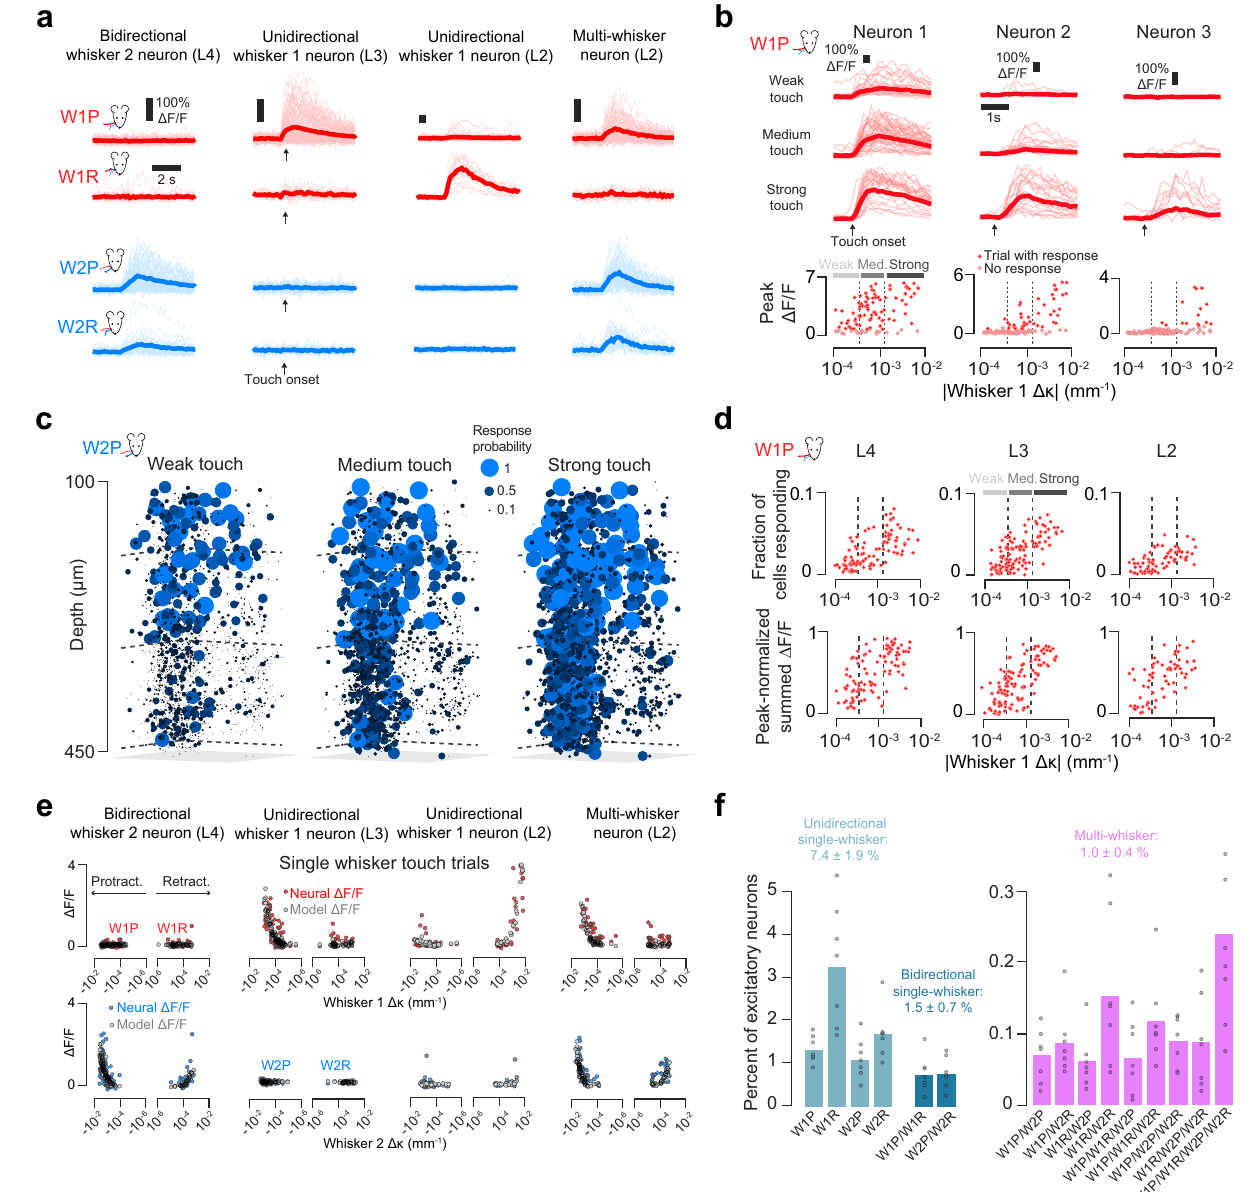
Fig.2|Classi fi cationoftouch-sensitiveneurons.a Example Δ F/Fresponsestoall single-whisker touchtypesforfour neurons. Thickline,mean;thinlines,individual touch responses. b Example responses to W1P touch for three neurons. Top, Δ F/F, grouped by touch intensity (weak: bottom third trial Δ κ ; medium: middle third; strong: top third; thick lines, mean; thin lines, individual touches). Bottom, responseasafunctionof Δ κ .Darkreddots,trialswithdetectedresponse;graydots, no response. Dotted vertical lines delimit the touch strength bins. c Response probability plotted for all neurons in an example mouse responding to weak,